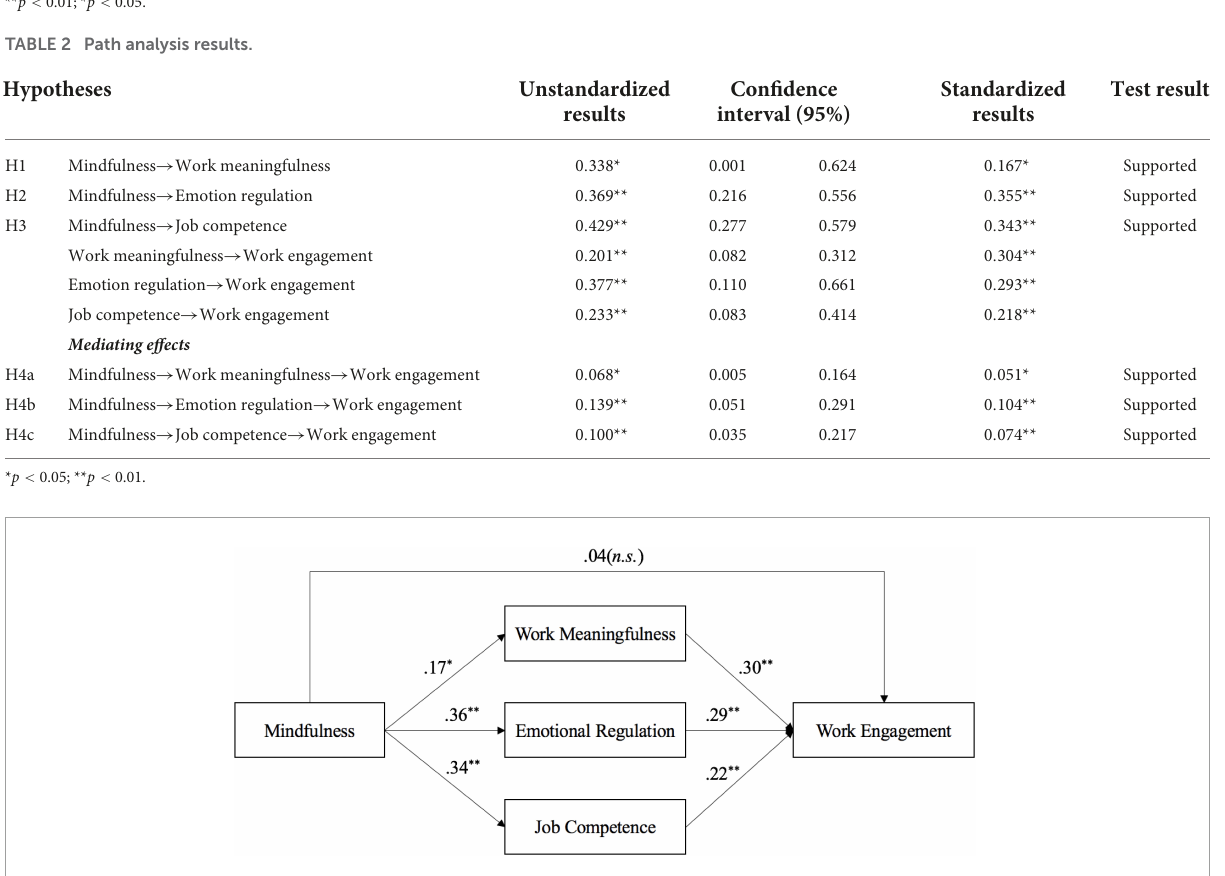
FIGURE1 Hypothesized theoretical model and results. Using mplus 7.0, N = 129. All of the reported paths are standardized coefficients. Control variables are job demands and job resources rated at Time 1, demographic variables including age, gender and marital status, as well as the respective variables rated before our intervention. *p < 0.05; **p <